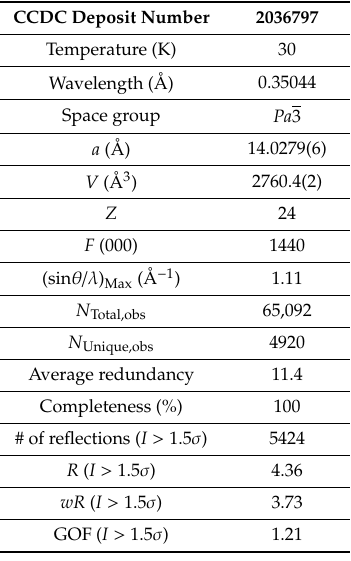
Table A1. Summary of the crystallographic data of C 60